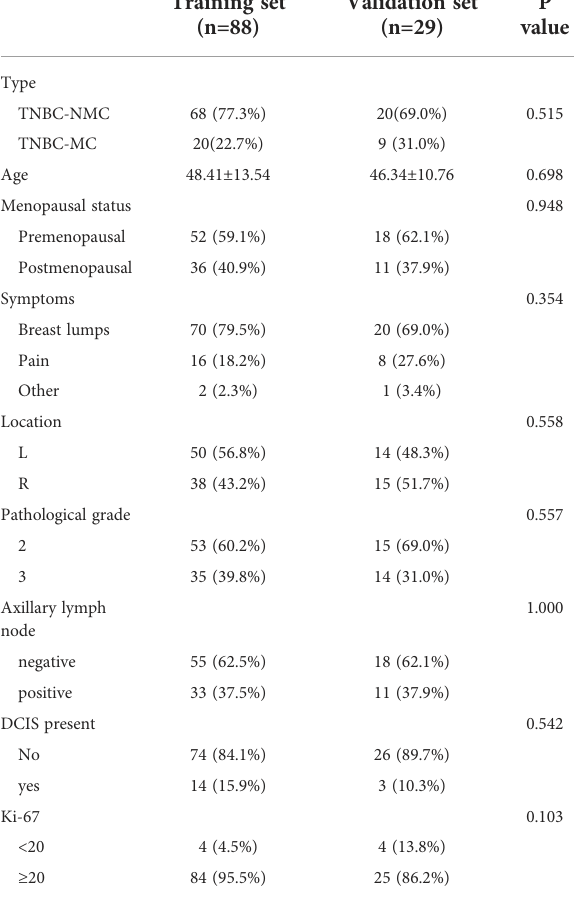
TABLE 2 Patient clinical and pathological information of MC and NMC in training set and validation set. Training